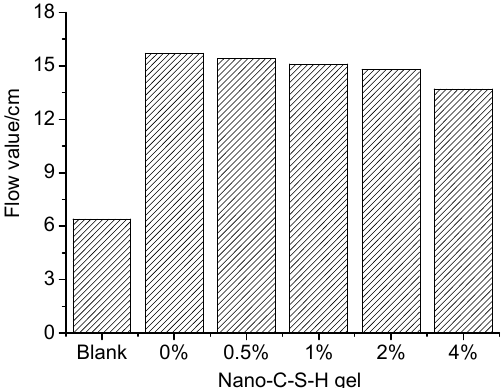
Figure 7. E ff ect of the nano-C-S-H gel on the fluidity of the fresh cement paste with 0.2 wt.% sucrose as the retarder.